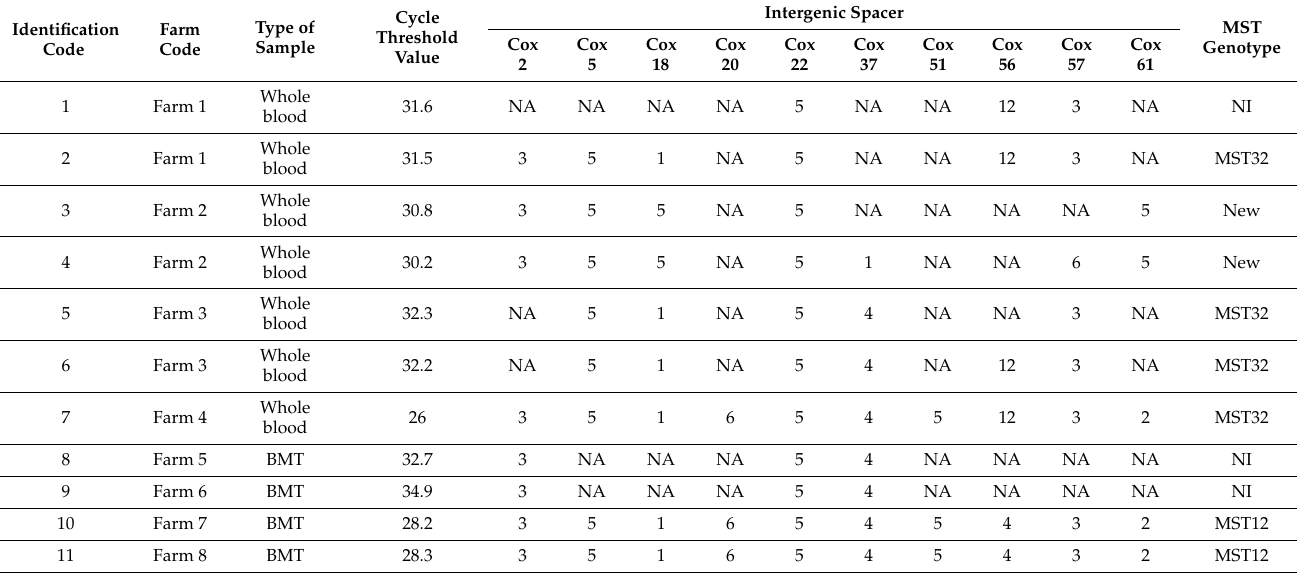
Table 2. Results of qPCR quantification and MST genotyping of Coxiella burnetii DNA in cows in Setif region,